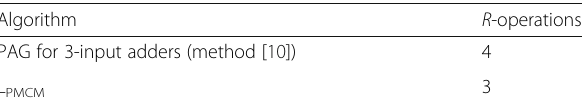
Table 7 Resulting R -operations for Example 4 using n = 3 input adders